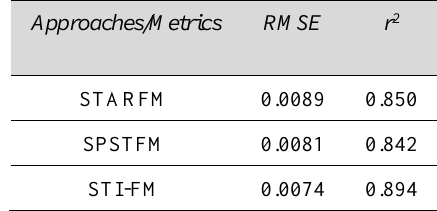
Table 1: Quantitative comparison of the actual and synthetic Lnadsat-7 images in January 11, 2002 for the red band from STARFM, SPSTFM, and STI-FM